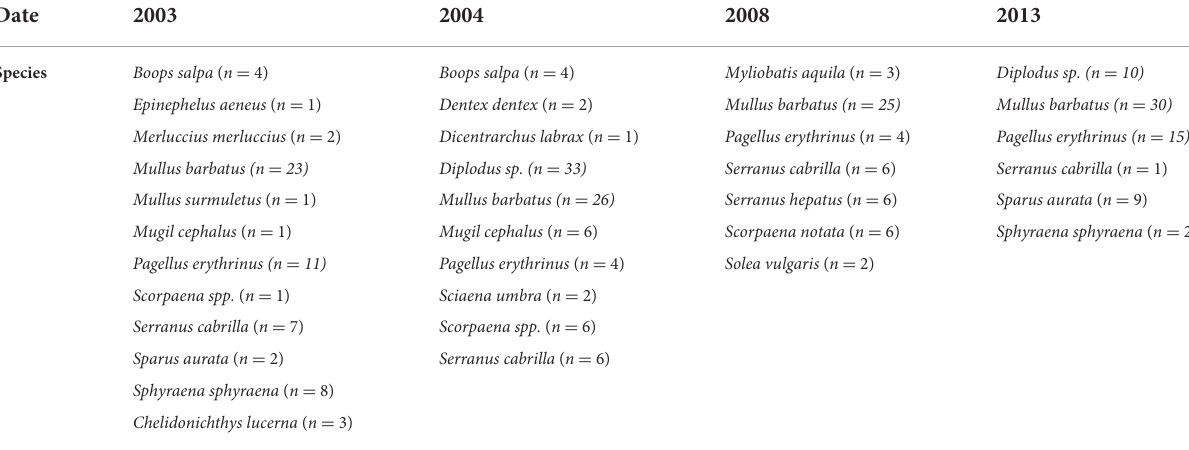
TABLE 2 List and number of collected finfish species in Augusta Bay sampling